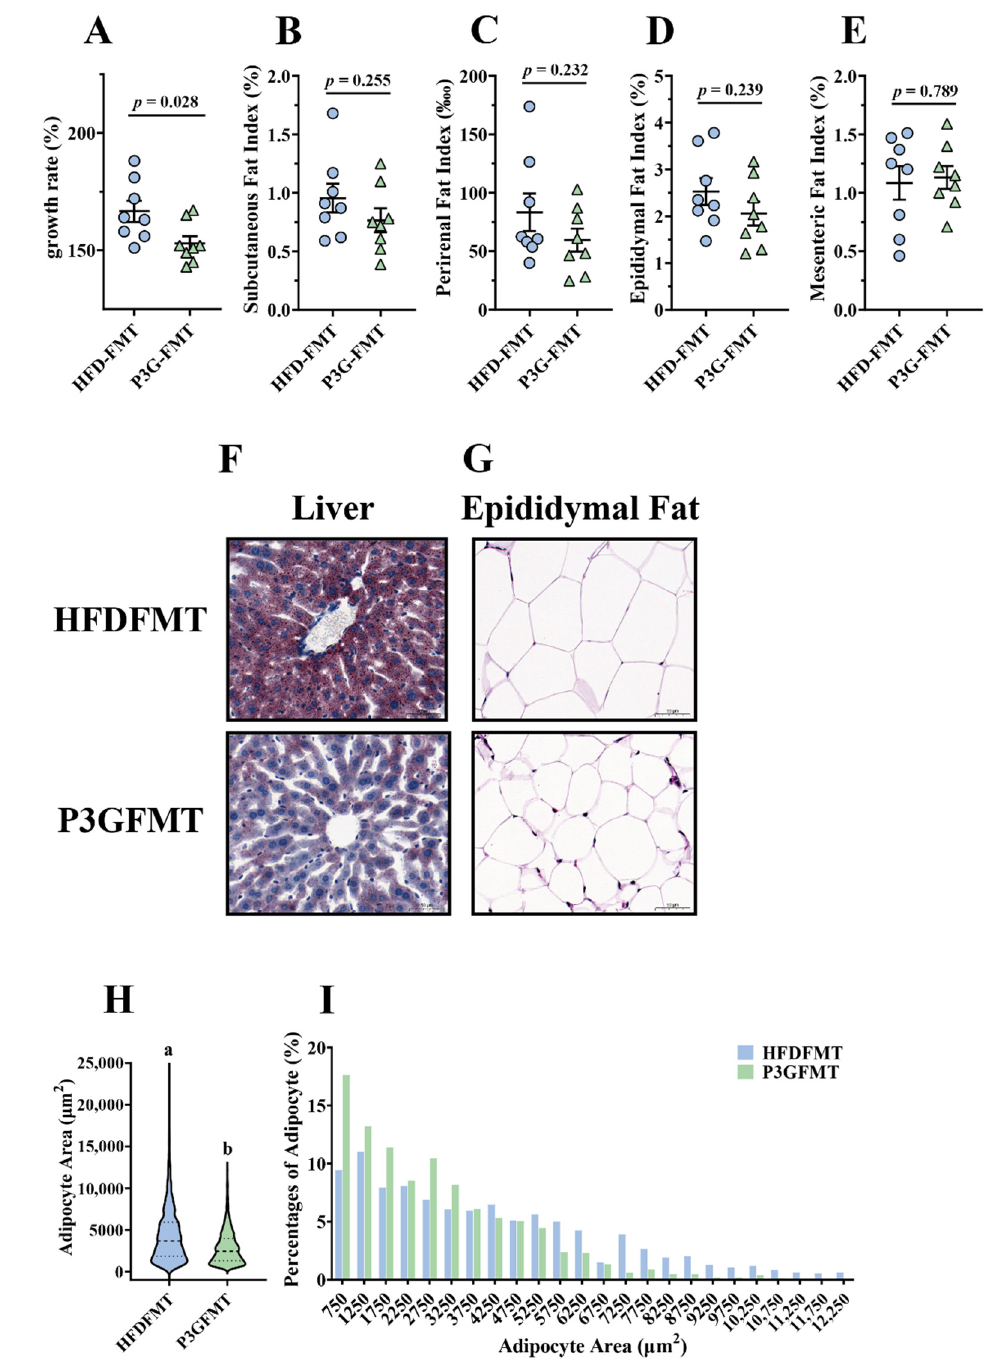
Figure 6. Fecal transplantation alleviated obesity and related metabolic disorders in obese mice: ( A ) growth rate within 12 weeks; ( B ) subcutaneous fat index; ( C ) perirenal fat index; ( D ) epididymal fat index; ( E ) mesenteric fat index; ( F ) representative pictures of Oil -Red-stained liver tissue (scale bar, 100 µ m); ( G ) representative pictures of hematoxylin and eosin (H&E)-stained epididymal adipose tissue (scale bar, 100 µ m); ( H , I ) epididymal adipocyte size (adipocyte size was estimated using the ImageJ software). Data are expressed as mean ± standard error (mean ± SEM) and were analyzed using the two-tailed Student’s t -test; a and b represent significant differences between groups. The same letter indicates no significance between the two groups, and different letters indicate significance ( p <